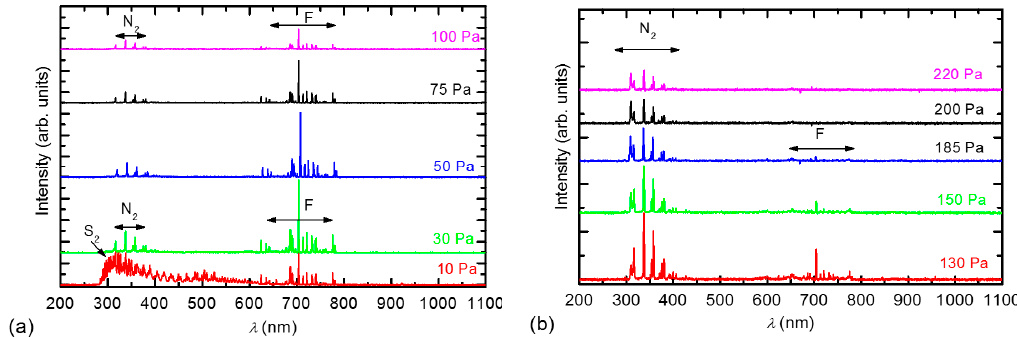
Figure 7. OES spectra of SF 6 plasma at various pressures: ( a ) below the threshold pressure and ( b ) above the threshold